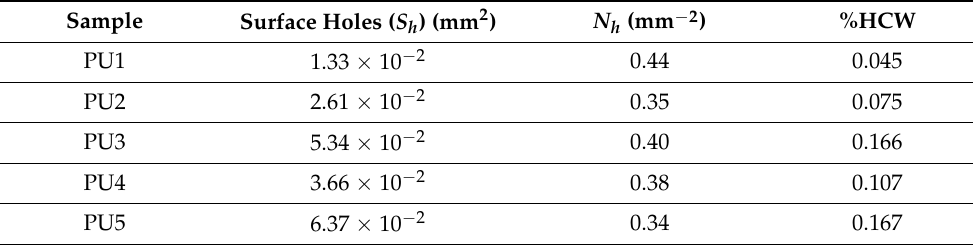
Figure 3. Cell size distribution and scanning electron micrographs of all the samples. Table 2. Structural parameters of the foams under